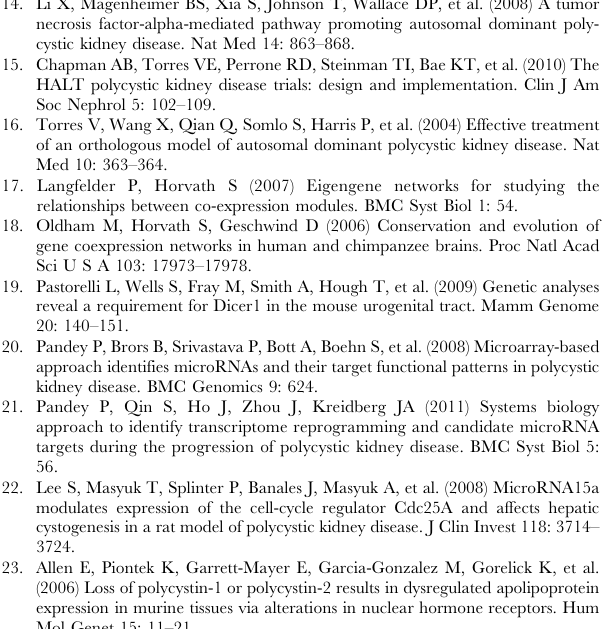
Table S1 List of genes in mutant-signature. (XLS) Table S2 Gene Ontology Biological Processes classification of genes in mutant-signature. Table S3 Genes in ME2 module. (XLS) Table S4 Gene Ontology Biological Processes classification of genes in ME2 cluster. Table S5 Genes in Turquoise module. (XLS) Table S6 Gene Ontology Biological Processes classification of genes in Turquoise module. Table S7 Quantile-normalized microRNA expression data. (XLS) Table S8 GEO datasets used for meta-analysis. (XLS) Table S9 Module membership of genes in meta-analysis. (XLS) Table S10 Gene modules identified in meta-analysis containing genes in either the mutant-signature or that normally change between P12 and P14 (age switch).